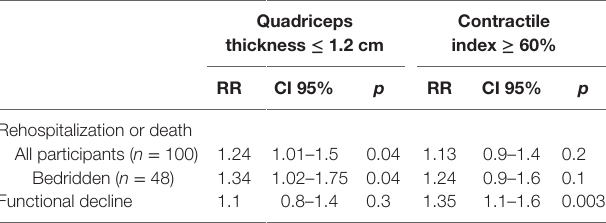
TaBle 4 | Risk for clinical outcomes by ultrasonographic and mobility tests variables.